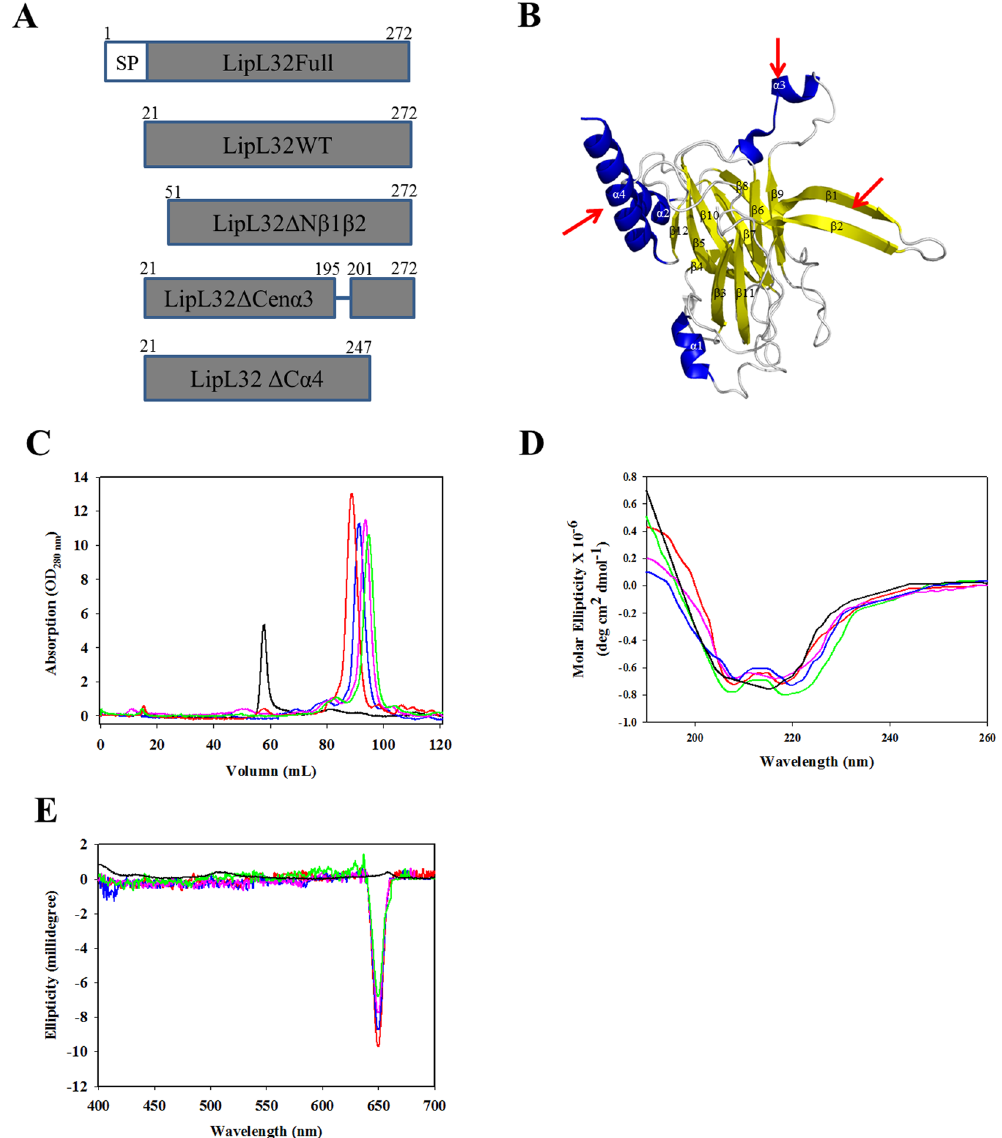
Figure 1. Characterization of LipL32 truncation variants. ( A ) The cartoons show the construction of LipL32 truncation variants. SP, signal peptide. ( B ) Three dimension structure of LipL32 and its relative domains. Blue, α -helix; Yellow, β -sheet; Gray, random-coil; red arrows, active motifs for TLR2 interaction. ( C ) Size exclusion chromatography (SEC) of purified TLR2 protein and LipL32 variants. TLR2 protein and LipL32 variants were purified as described in Materials and Methods and SEC was used to identify the integrity and purity of these proteins. ( D ) Circular dichroism (CD) of purified TLR2 protein and LipL32 variants purified. The secondary structure of purified TLR2 protein and LipL32 variants were measured by CD spectroscopy and the spectra were record between 260 nm and 190 nm. ( E ) Ca 2 + binding assay by stains-all assay. The Ca 2 + binding activity of LipL32 variants were tested by stains-all and the J band at 660 nm was measured. TLR2 protein was used as negative control. Black, TLR2 protein; Red, LipL32WT; Blue, LipL32 Δ Cen α 3; Pink, LipL32 Δ C α 4; Green, LipL32 Δ N β 1 β 2 in Figure ( C – E